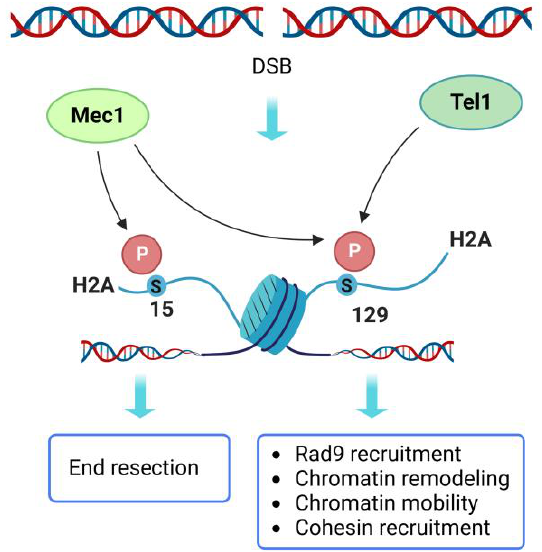
Figure 3. Phosphorylation of histone H2A promotes HR in S. cerevisiae . Tel1- and Mec1-dependent phosphorylation of H2A S129 ( γ -H2A) regulates both negatively and positively DNA end resection by recruiting Rad9 and chromatin remodeling enzymes, respectively. γ -H2A also increases chromosome mobility, thus favoring homology search, and promotes cohesin recruitment to the DSB ends. Mec1-dependent phosphorylation of H2A S15 stimulates DNA end resection and promotes HR repair. Created with BioRender.com.